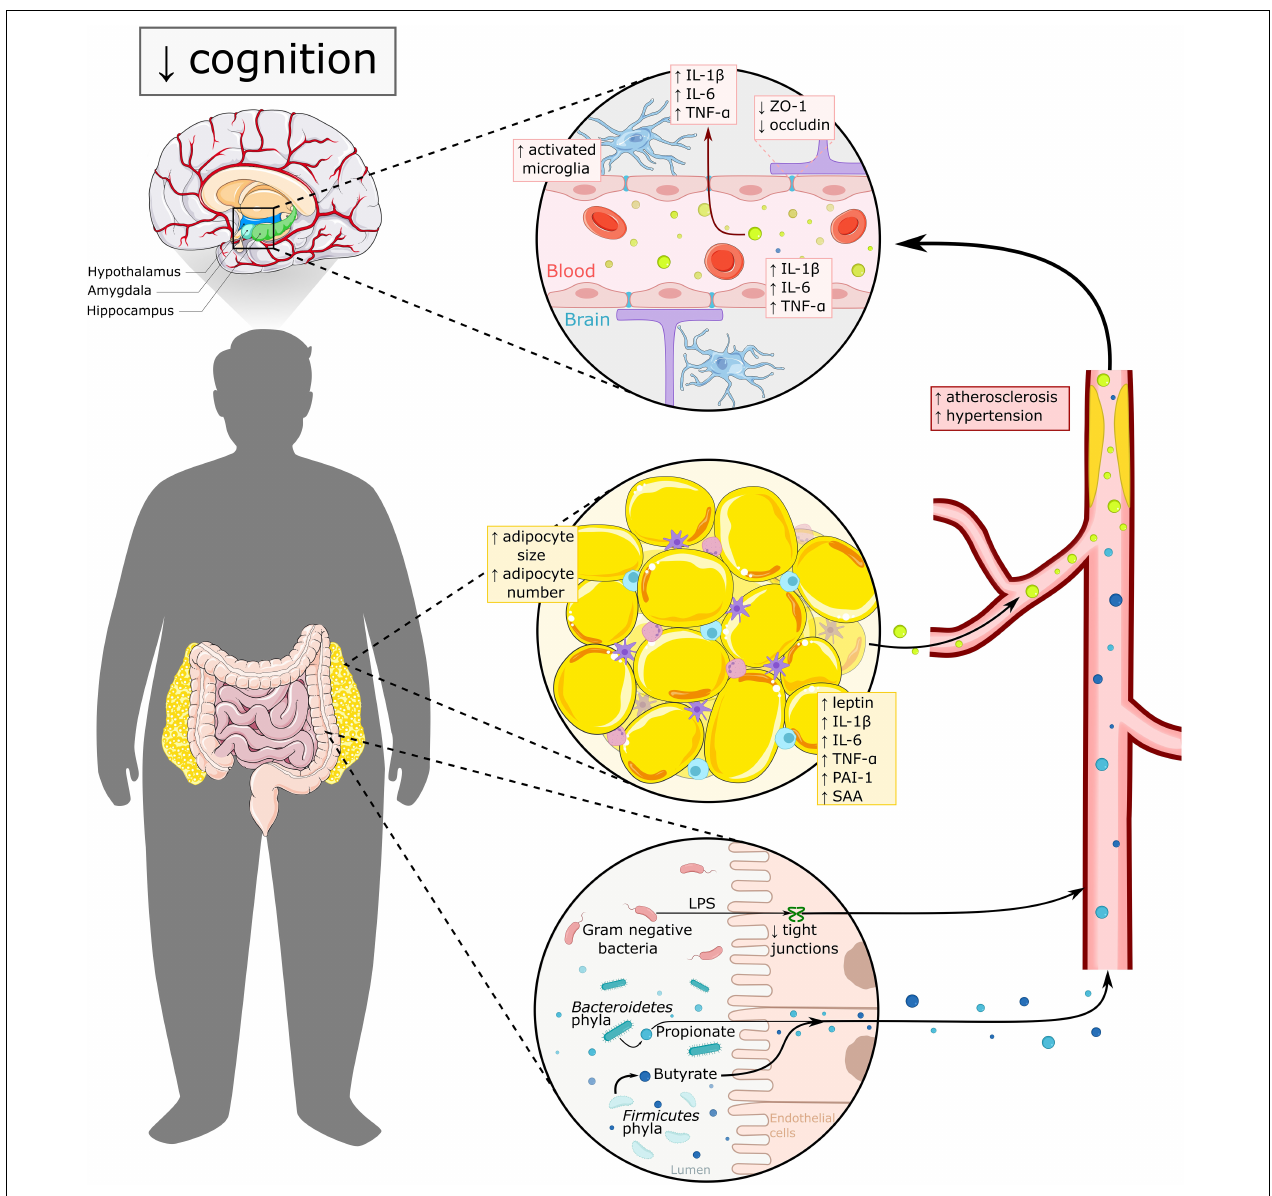
FIGURE 2 | Overview of mechanisms underlying cognitive impairment in obesity. Both excess WAT and altered gut microbiota have a direct and indirect effect on brain functioning. In dysbalanced WAT, adipocytes secrete pro-inflammatory adipokines in the circulation, leading to a more pro-inflammatory state. Adipokines like leptin, PAI-1 and SAA thereby, affect vascular health via promoting atherosclerosis, hypertension and thrombosis. Gut microbiota in obesity is linked to higher levels of LPS and increased gut permeability, which may contribute to increased systemic inflammation. Both excess WAT and altered gut microbiota add to blood brain barrier (BBB) dysfunction, which leads to increased neuroinflammation amongst other. The hypothalamus, amygdala and hippocampus seem to be the most vulnerable regions for obesity related changes and are all three highly important in cognitive functioning. IL-1 β , interleukin 1 β ; IL-6, interleukin 6; PAI-1, plasminogen activator inhibitor 1; TNF- α , tumor necrosis factor α ; SAA, serum amyloid; ZO-1, zonulin-1; LPS,